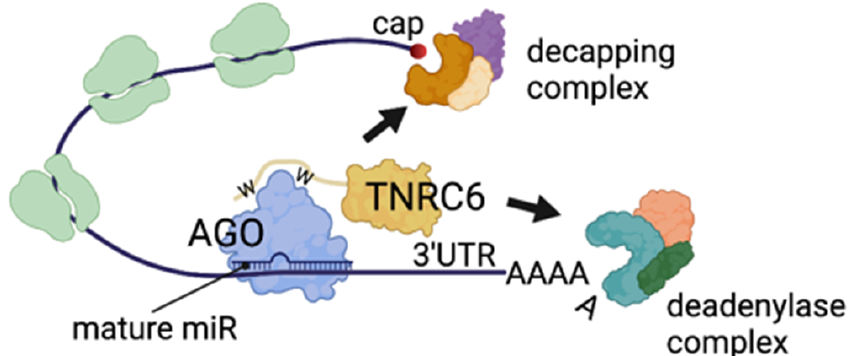
Figure 1. Mechanisms of PTGR mediated by AGO-containing complexes. A mature miR guides AGO and TNRC6 to a partially complementary binding site within the 3’ UTR of a target mRNA. Following AGO/TNRC6 binding, decapping and deadenylase complexes are recruited on the target mRNA. Mammalian genomes encode for three highly regulated TNRC6 paralogues, GW182/TNRC6A, TNRC6B, and TNRC6C [13,14], which are functionally redundant [15]. Upon deadenylation and decapping, mRNAs become s substrate for cellular exonucleases, and are rapidly degraded (reviewed in [16]). As mammalian TNRC6 paralogues lack catalytic activity, it is conceivable that they do not play any “solo” roles in the cell. W indicates key tryptophan residues on TNRC6 for binding to AGO. Therefore, AGO, the miR, and TNRC6 constitute the core of the miR-induced silencing complex (miRISC) [17], the effector machinery that mediates PTGR in the cytoplasm. miRISC-mediated PTGR accounts for the repression of more than half of metazoan protein- coding genes [18], representing a layer of post-transcriptional gene repression involved in virtually all cellular processes. As AGO and TNRC6 are utilized prevalently in the miRISC-mediated PTGR, they are enriched in the cytoplasm in most cell types. However, they can also be found in the nucleus [19–21], and can become further enriched in this compartment under specific conditions, such as during stress